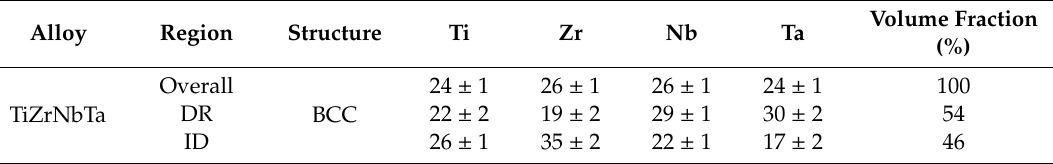
Table 2. Emission electron probe micro-analyzer (EPMA) results of the as-cast Ti 25 Zr 25 Nb 25 Ta 25 high-entropy alloy. Note that DR and ID refer to the dendrite and inter-dendrite region, respectively.